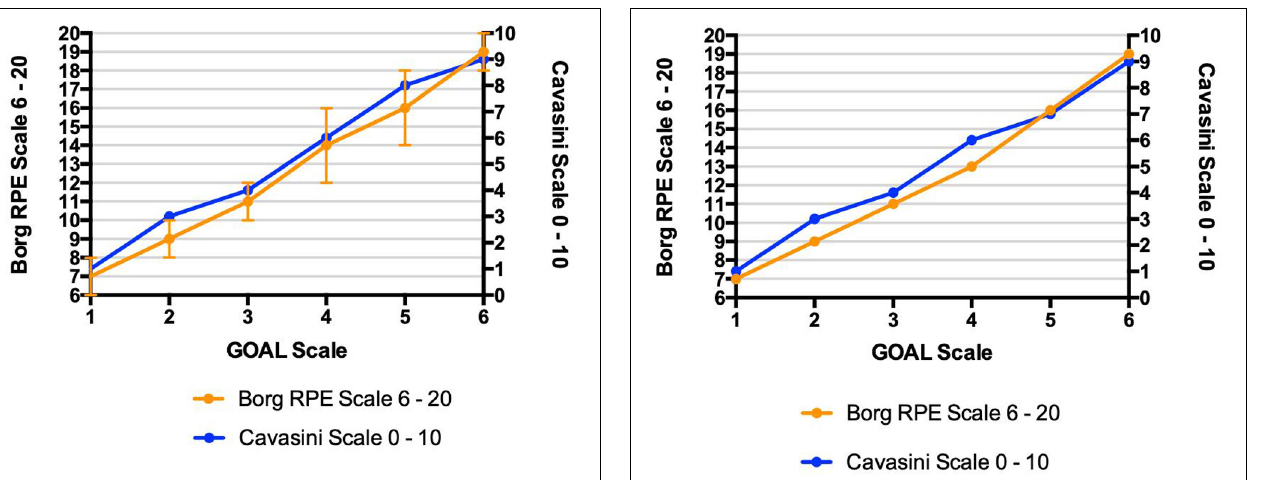
FIGURE 5 | Yo-Yo Test – Construct Validation Relationships among rating of perceived exertion identified by three different instruments (GOAL Scale, Borg